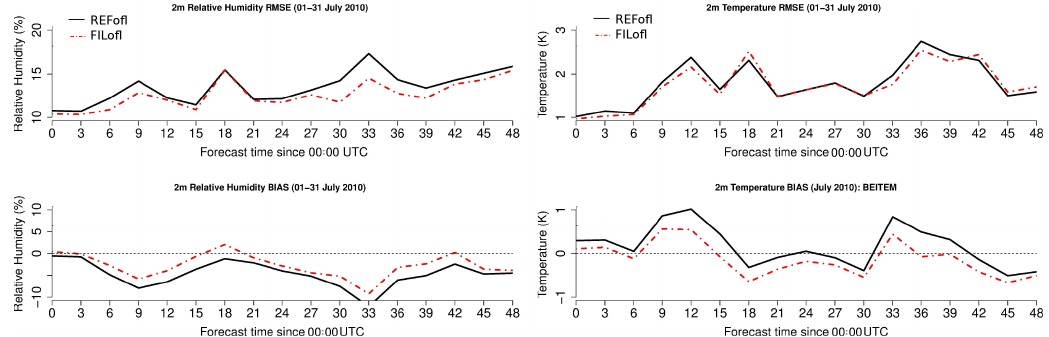
Figure 15. Forecast scores (BIAS and RMSE) for RH 2 m and T 2m for all forecast ranges of the runs at 00:00UTC averaged over July 2010 in Beitem (Belgium) for REFofl (black) and FIL1ofl (red).